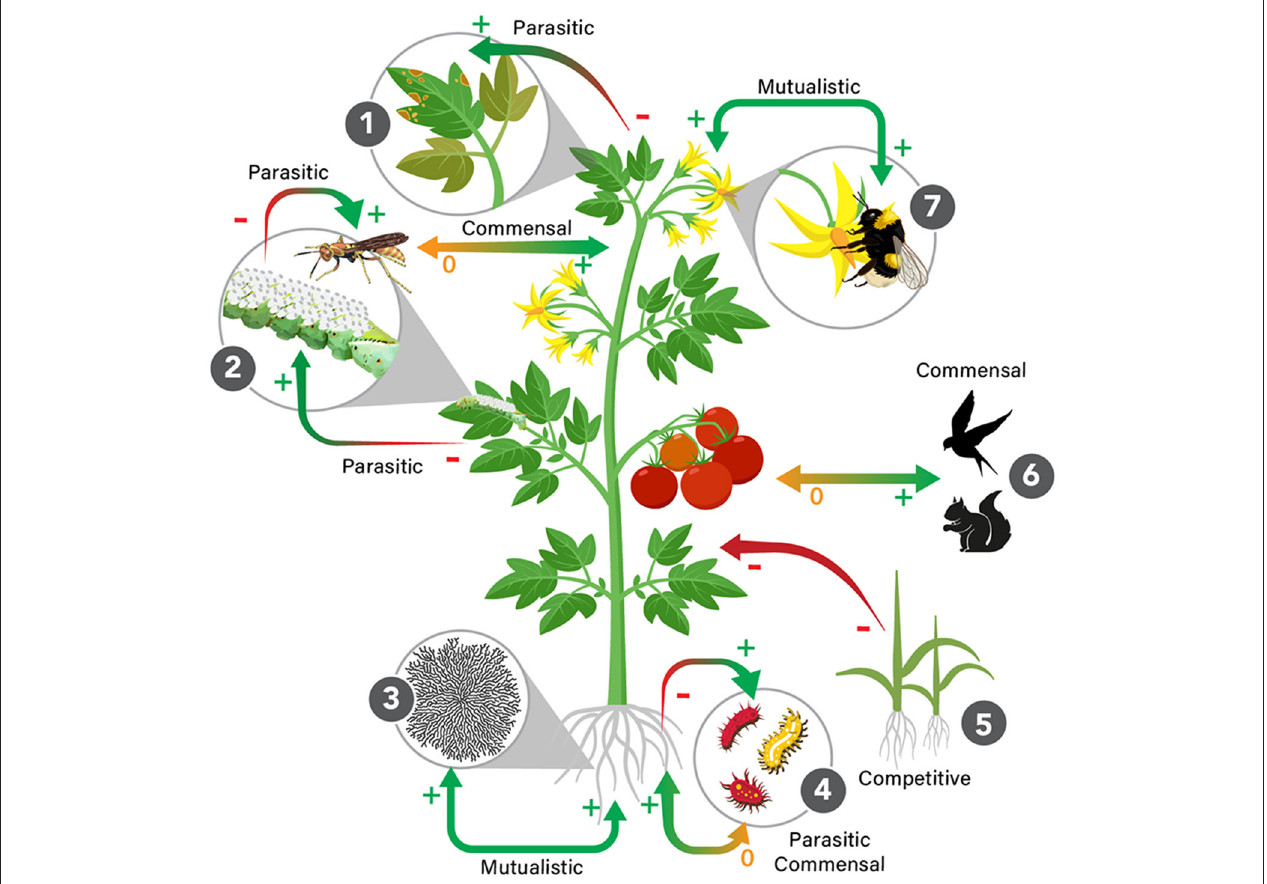
FIGURE 2 | Coevolutionary networks, such as the vertebrates, invertebrates, plants and microorganisms that interact with tomato plants ( Solanum spp.), result in species interactions with different levels of codependency. 1: common rust fungus can infect the tomato plant, leading to leaf mortality; 2: a wasp caterpillar parasite; 3: Arbuscular mycorrhyzal fungi (AMF) are plant symbionts; 4: invertebrates and microorganisms such as nematodes and bacteria can have detrimental effects on plant roots; 5: other plant species can compete with Solanum for nutrients and space crop fields; 6: frugivores benefit from consuming tomato fruits and disperse seeds; and 7: pollinators such as bees contribute to the plants reproductive output. 0 = neutral interaction, + = beneficial, – =